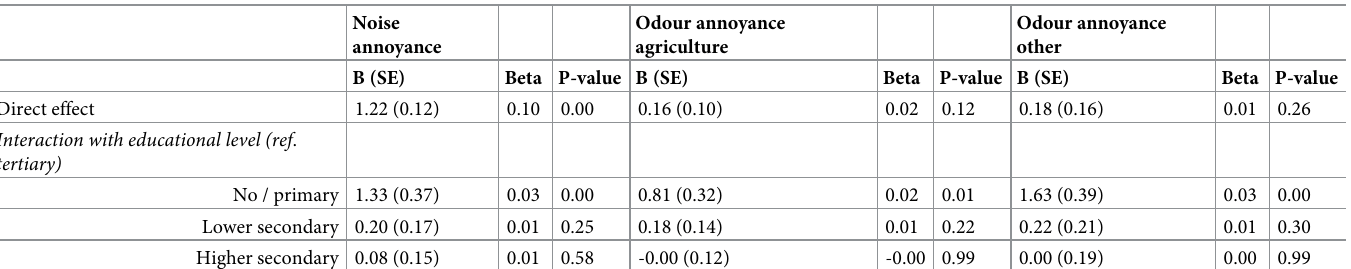
Table 5. Interaction effects of noise and odour annoyance for educational level.